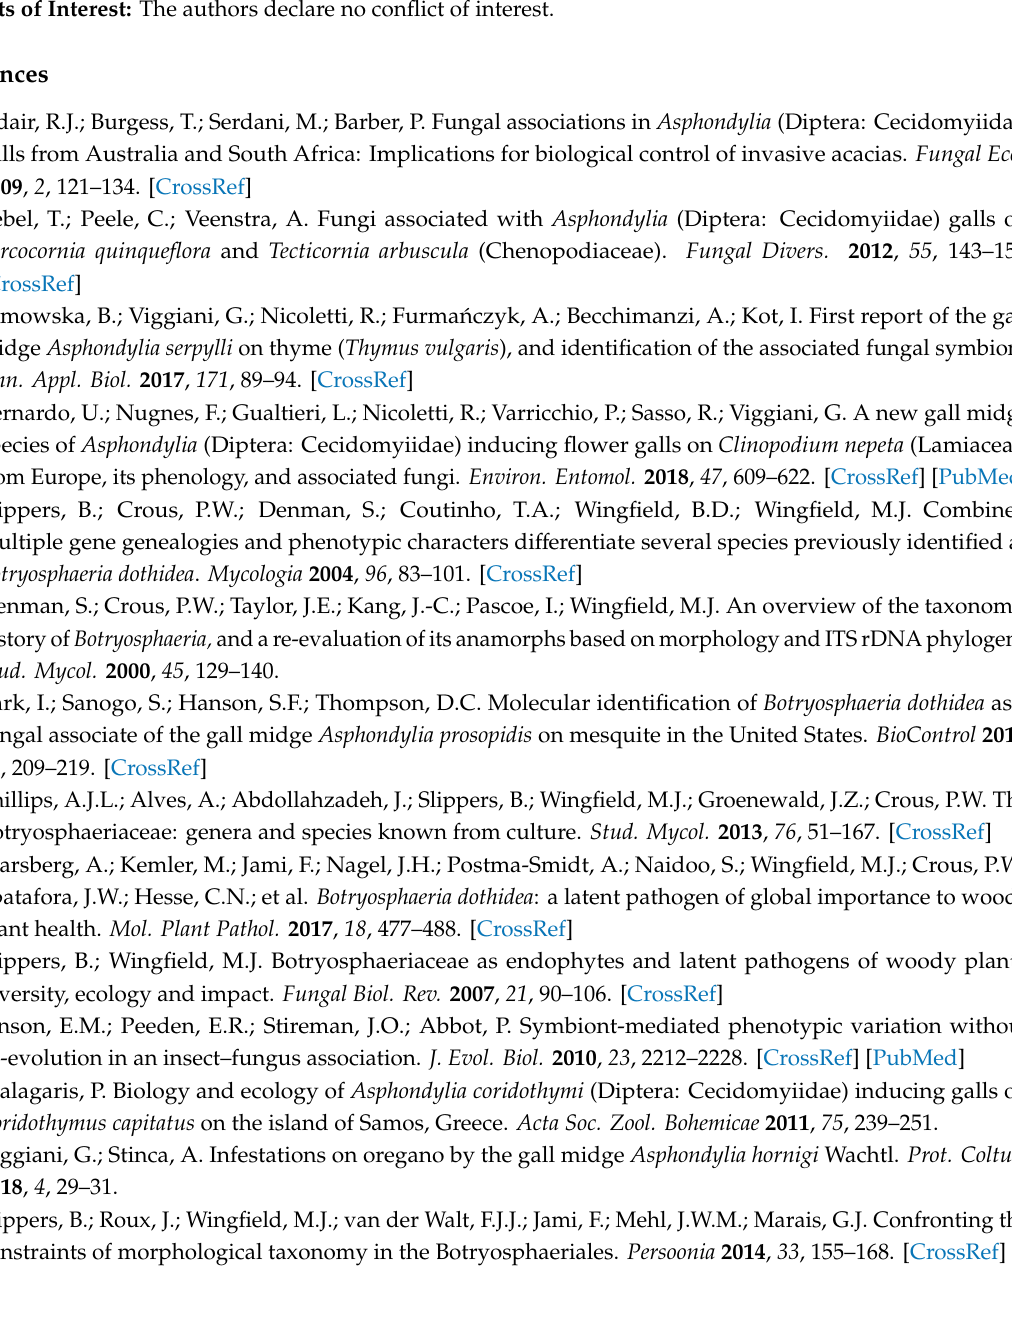
Figure S1: Maximum-likelihood tree of ITS sequence. Figure S2: Maximum-likelihood tree of EF sequence. Figure S3: One of the 1000 most parsimonious trees resulting from the analysis of concatenated ITS and TEF1